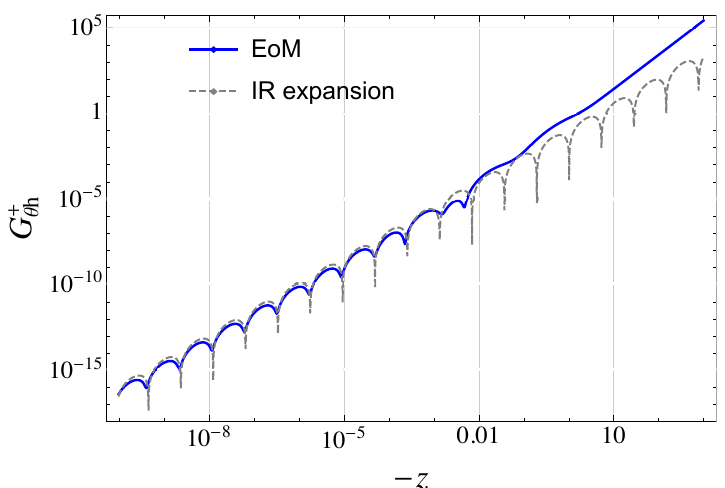
Figure 8 . The evolution of the component G + to z = k(cid:17) where the EoM approach is described in appendix A and the IR expansion is described in appendix